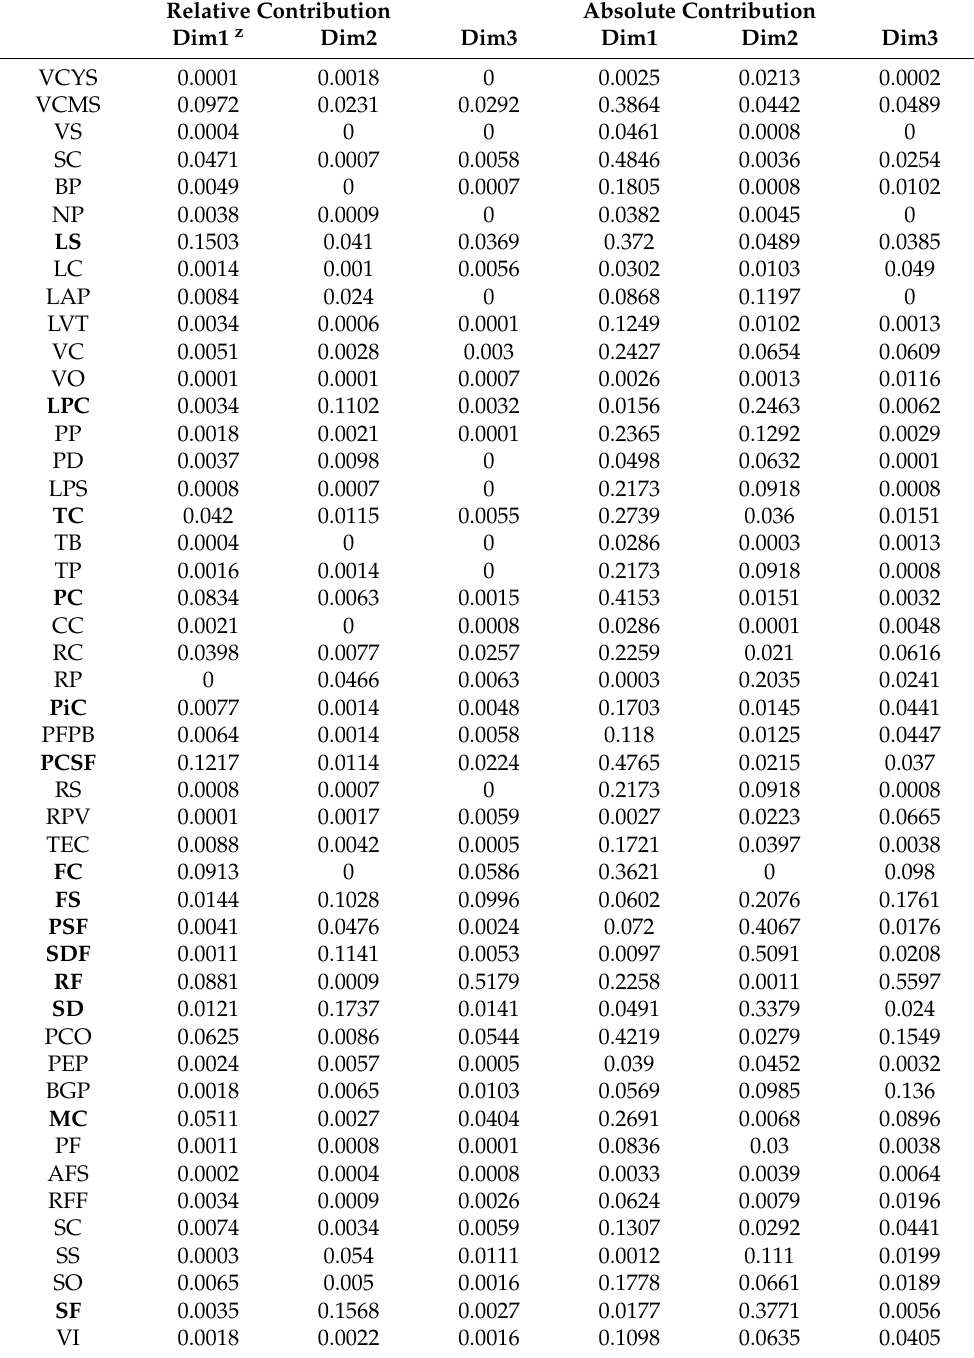
Table 1. Characteristic values and their relative and absolute contribution to the first three principal dimensions of the analysis of variability of Sechium edule